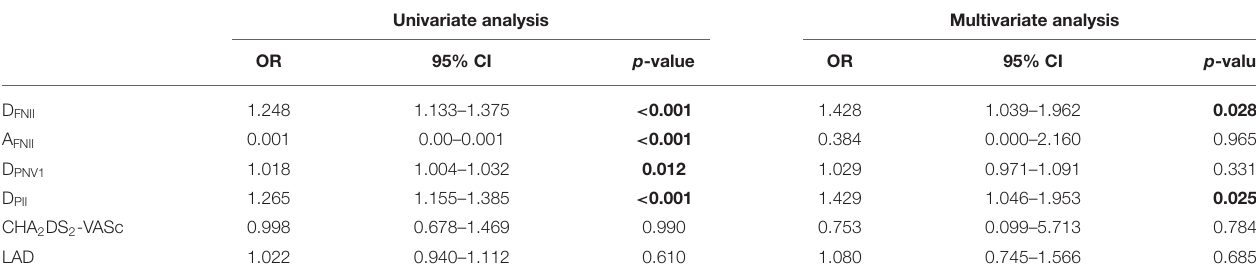
TABLE 2 | The univariate and multivariate Cox regression analysis for identifying predictors of new-onset atrial fibrillation.